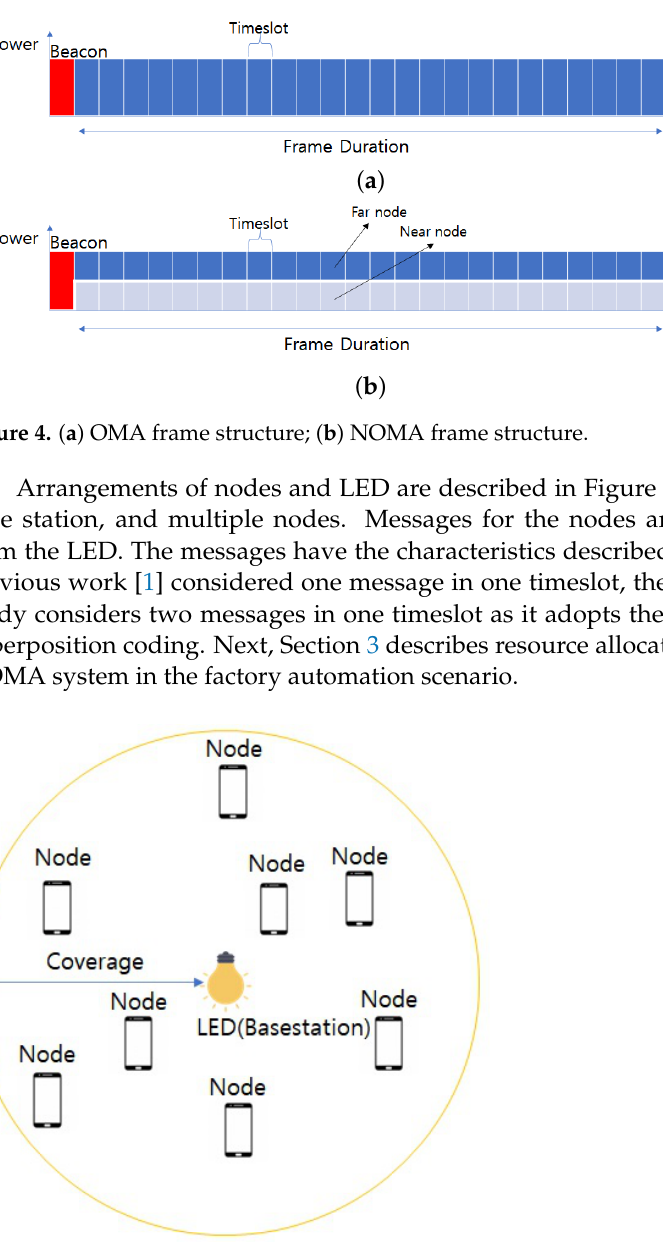
Figure 5. Deployed nodes and LED for factory